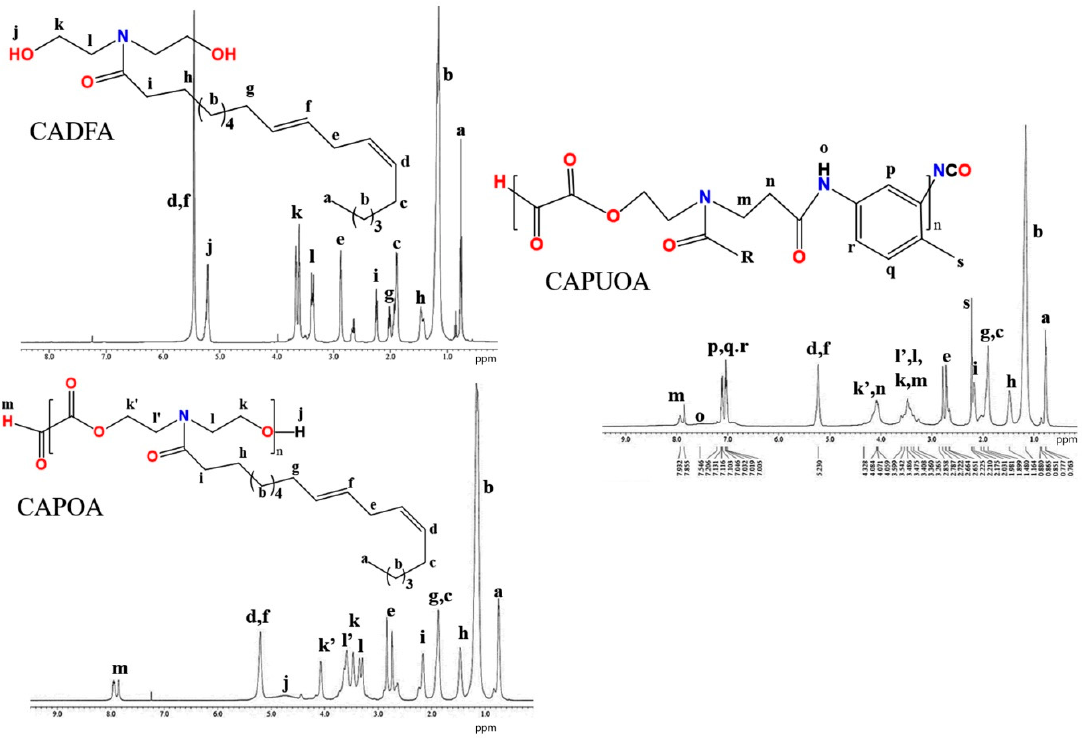
Figure 2. 1 H NMR spectra of CADFA, CAPOA, and CAPUOA.